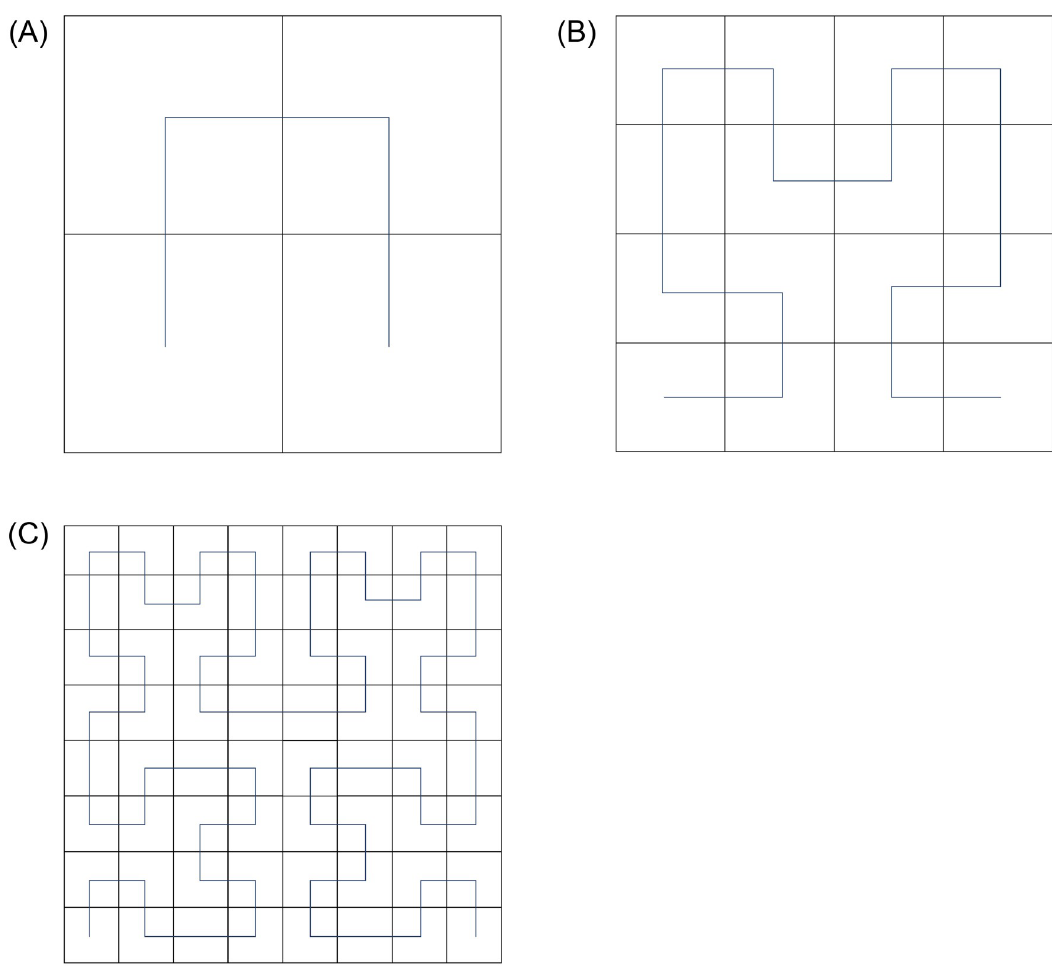
Fig 4. Hilbert curve of order 1, 2 and 3. A: Hilbert curve of order 1. B: Hilbert curve of order 2. C: Hilbert curve of order 3.